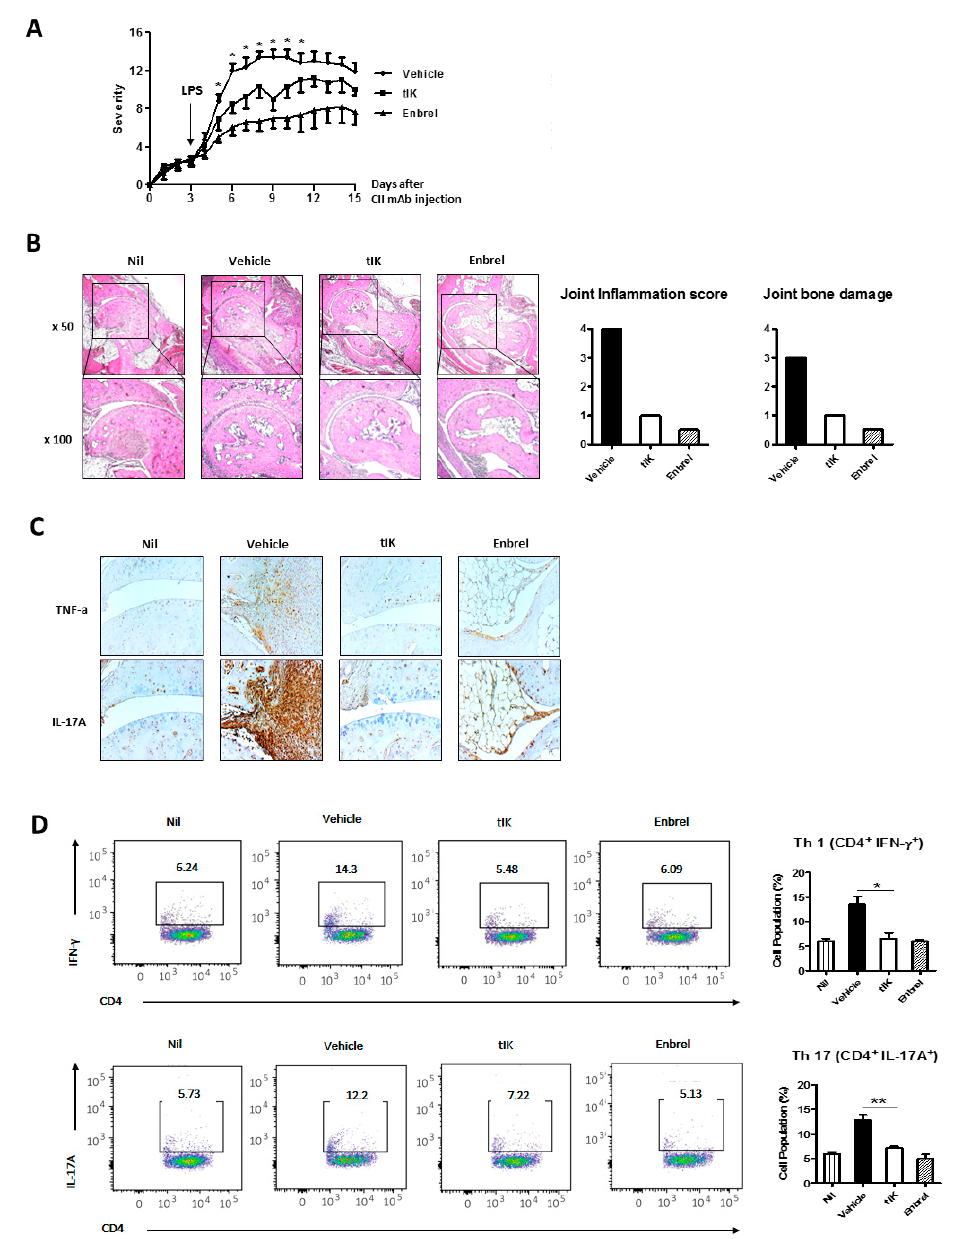
Figure 6. The injection of the exogenous tIK protein in a mouse model of RA alleviates the inflammatory symptoms. ( A ) The severity of arthritis in the CAIA model was scored every day. The severity of symptoms in each paw was scored on a scale from 0 (no symptoms) to 4 (maximal level of symptoms) and the scores for four limbs were summed; * p < 0.05, Enbrel or tIK vs. vehicle; The black arrow indicated the day of LPS treatment. ( B ) Hematoxylin and eosin (H&E) staining of the ankle joint tissue was performed to analyze tissue damage. A representative image was selected for each group ( n = 6–9); The black square indicated the enlarged area with x100. ( C ) Immunohistochemistry staining for the inflammatory cytokines TNF- α and IL-17A was performed. A representative image for each group was selected ( n = 6–9); ( D ) The percentages of Th1 and Th17 cells were analyzed using flow cytometry. Splenocytes were isolated and stained with anti-CD4-allophycocyanin (APC) as a surface marker and anti-IFN- γ -phycoerythrin (PE) or anti-IL-17A-PE as an intracellular marker. The pseudo-color dot plots represent cell distribution in CD4 + T cells and the cells gated in the box express IFN- γ or IL-17A; the bar graph shows mean percentages. Data is represented as the mean ± SD ( n = 3), * p < 0.05, ** p <0.005.